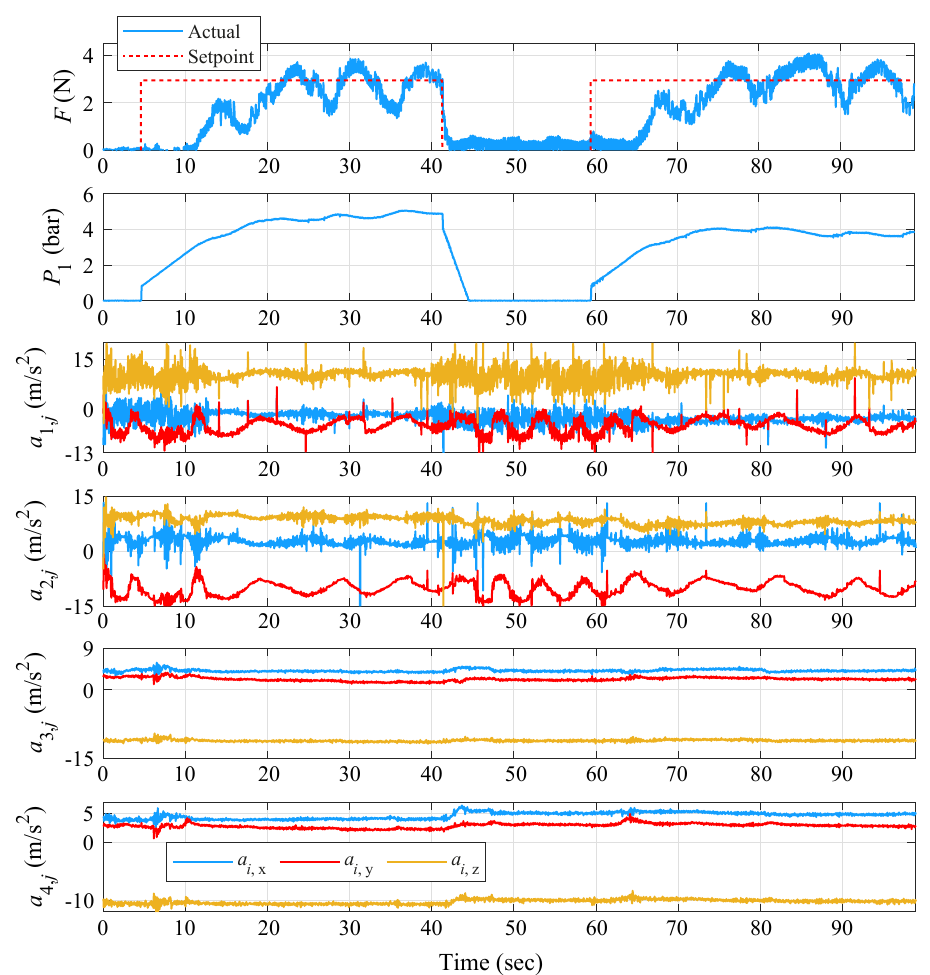
Figure 13. Experimental evaluation of iteration (A) and the effect of applying resisting force to the ET-diagnosed volunteer’s index finger under closed-loop reference in applied pressure, while performing finger-bending motions that finish with touching a spherical object; Exp.